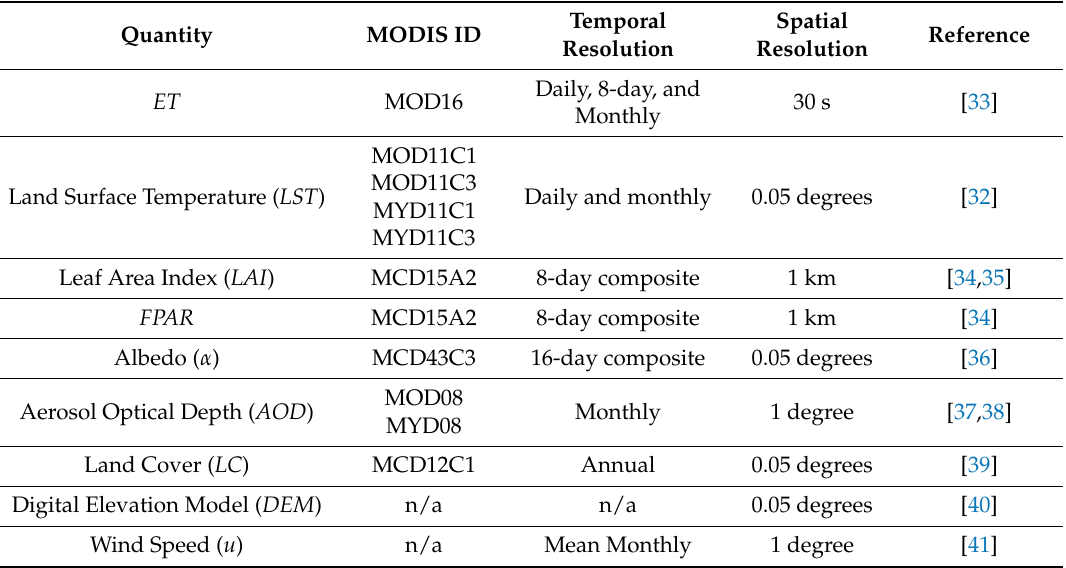
Table 1. Descriptions of key datasets used in this